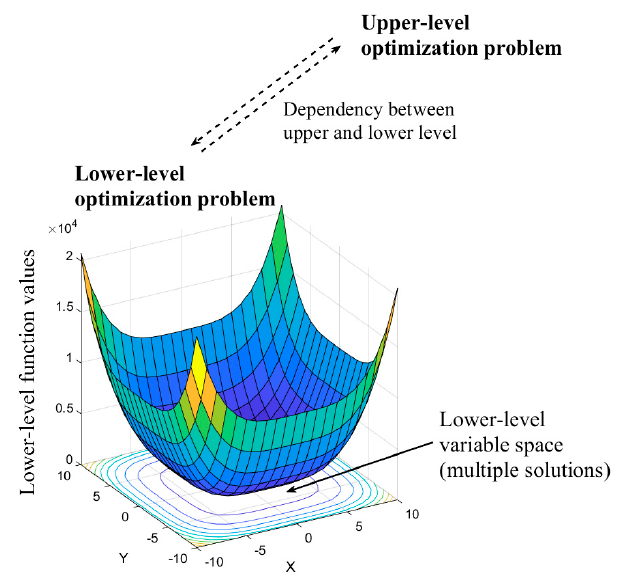
Figure 1. Graphical Representation of a bi-level Optimization Problem.